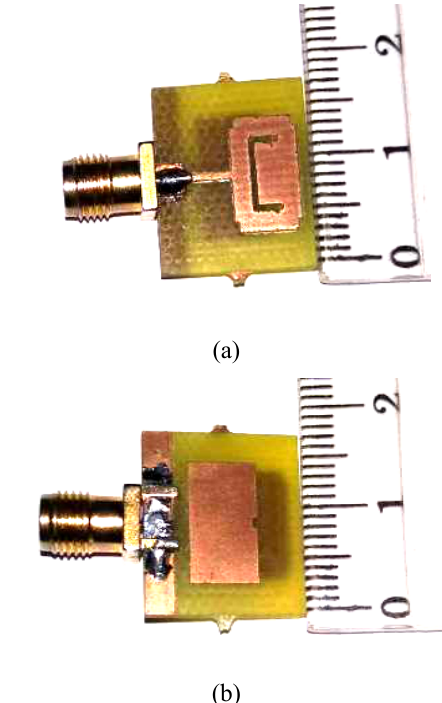
Fig.8. The fabricated antenna (a) Top view and (b) Bottom view.